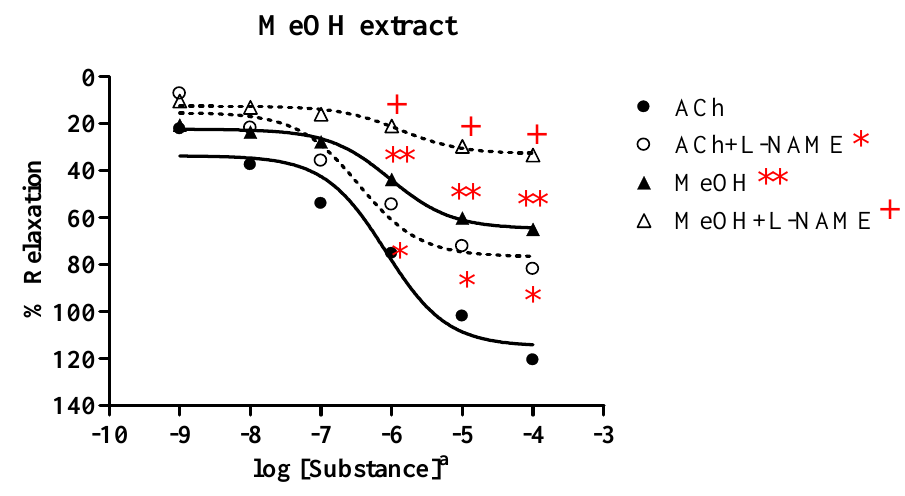
Figure 5. Effect of MeOH extract and ACh on the vascular function of rat thoracic aorta in the absence and presence of 1 mM